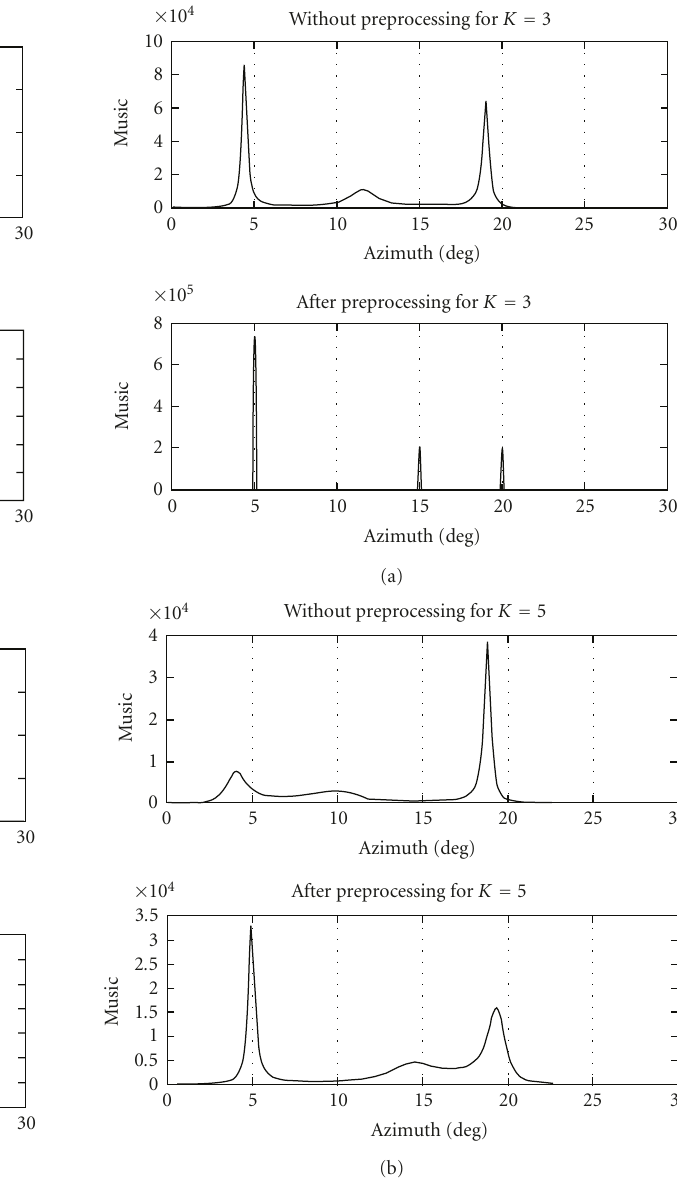
Figure 10: Localization of the three sources at 5 ◦ , 15 ◦ , and 20 ◦ without and with noise preprocessing for K = 3 and K =